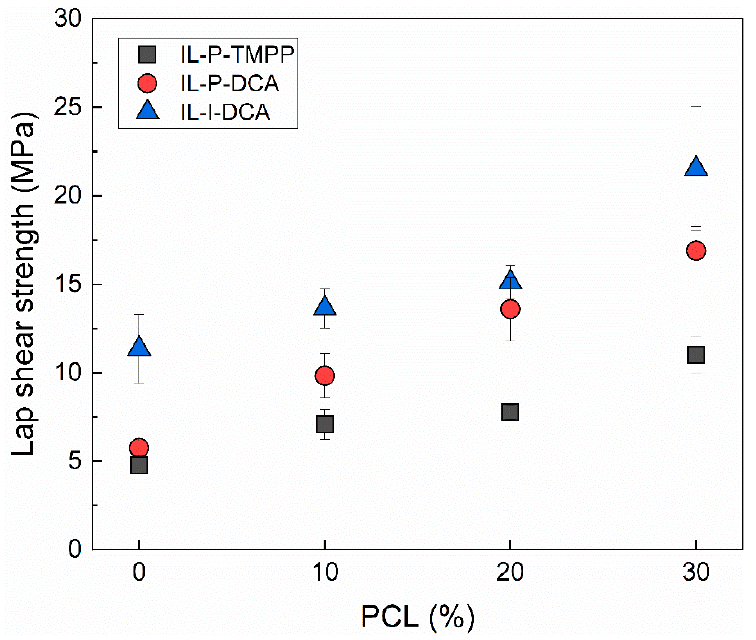
Figure 6. Lap shear strength of the IL-cured epoxy/PCL blends as a function of the PCL content.